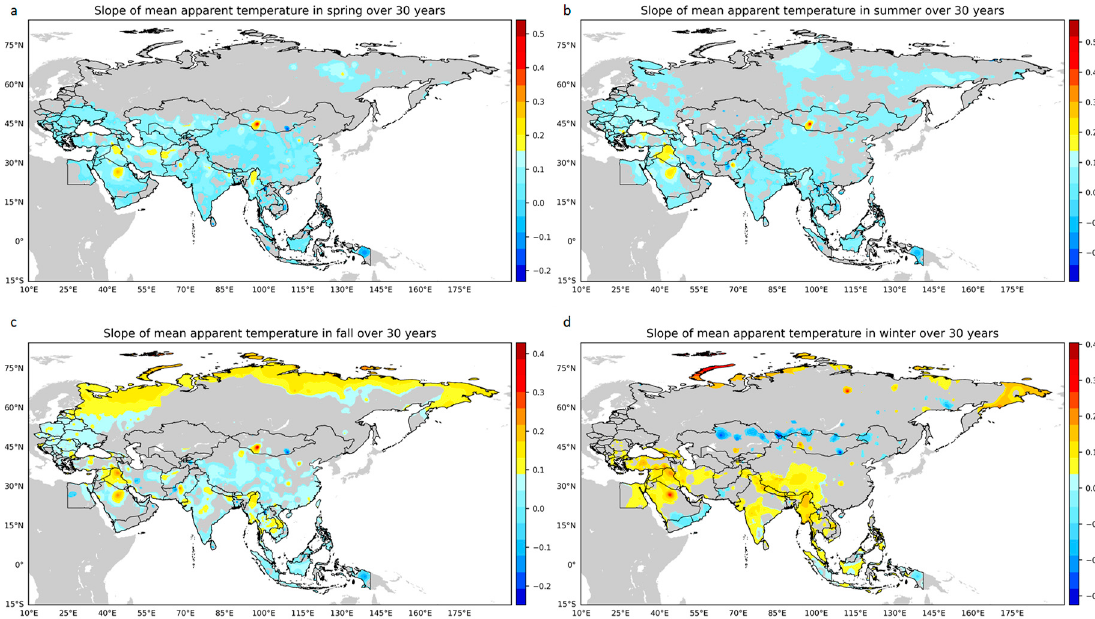
Figure 6. Slope of mean apparent temperature for: (a) spring, (b) summer, (c) autumn, (d) winter.